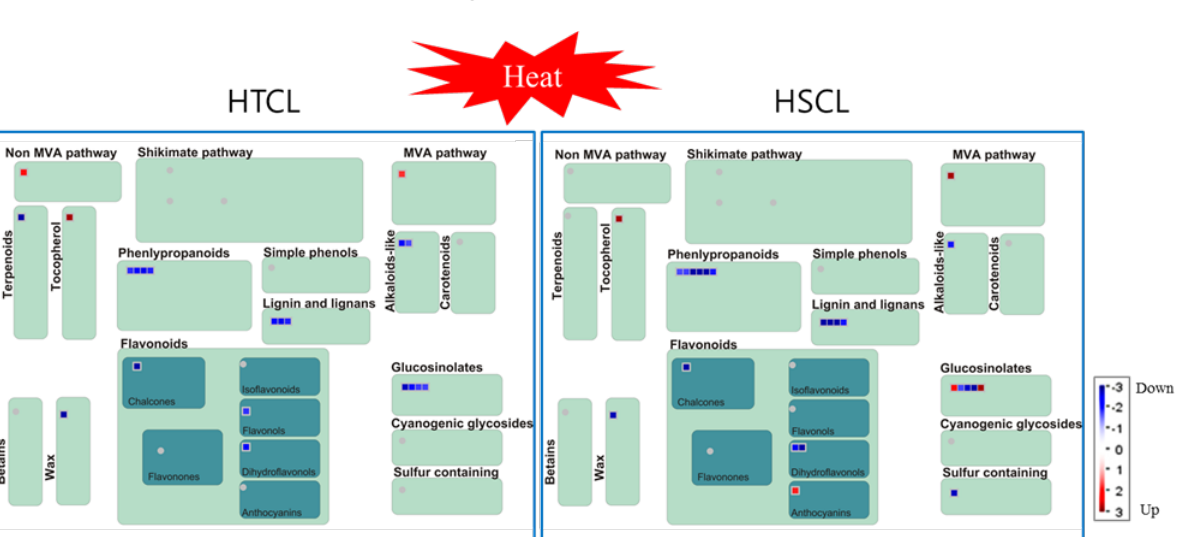
Figure 7. Molecular secondary metabolism events in heat stress-tolerant and heat-sensitive cabbage inbred lines in the heat stress condition. Differentially expressed genes are depicted by MapMan format (ver. 3. 5. 1), in which the square represents a gene. Red and blue colors depict up- and down-regulated genes, respectively. Gene data were examined by MapMan analysis, which is provided in Table 3. HO, heat stress-tolerant cabbage inbred line; JK, heat stress-sensitive cabbage inbred